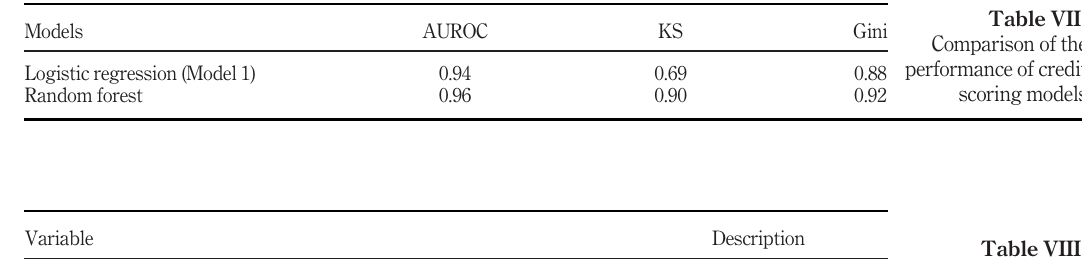
Table VIII. Quadratic